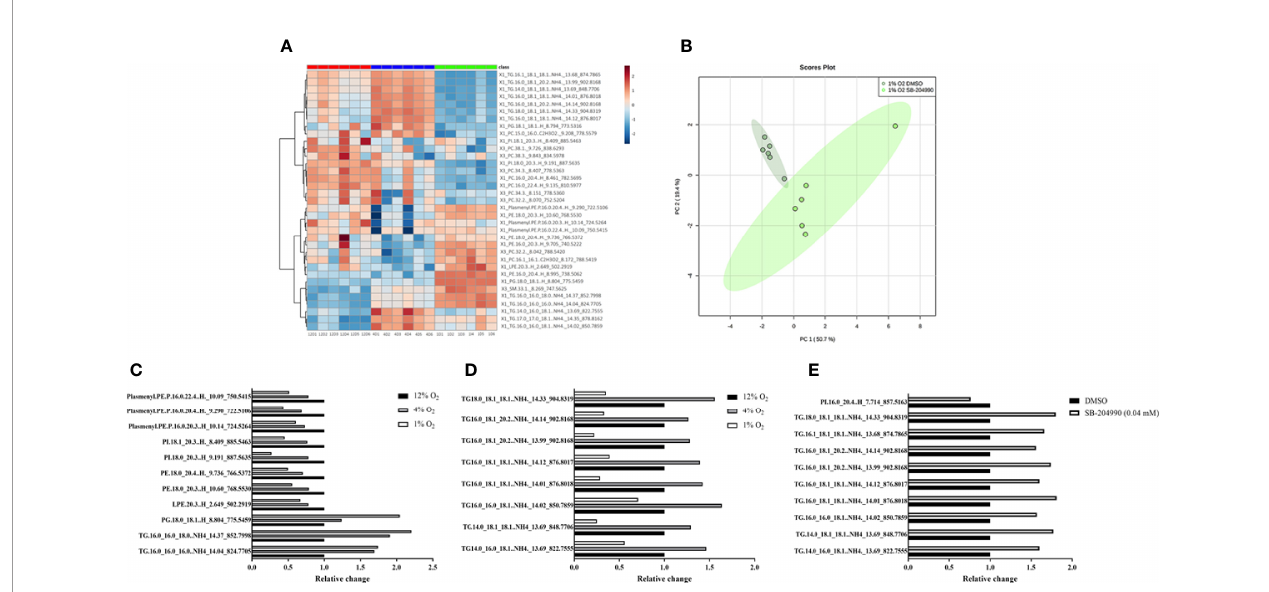
FIGURE 2 | The Effect of Hypoxia on Lipidomic Pro fi le. The effect of hypoxia on intracellular lipidomic pro fi le based on ANOVA FDR p-value < 0.01 and PLS-DA VIP score > 1. Data are presented as HCA map with colorful visualization of log 2 FC (Fold change) – (A) . The effect of hypoxia and ATP-dependent citrate lyase inhibition (40 m M SB-204990) on clustering of cell samples in 1% O 2 . Data are presented as PCA Score plot (B) . Lipids with increased intensity with progression of hypoxia ( C , p < 0.01). Lipids with “ up and down ” pattern (increased at 4 % O2, decreased at 1% O 2 ) ( D , p < 0.01). Lipids affected by ACLY inhibitor at 1% O 2 ( E , p <